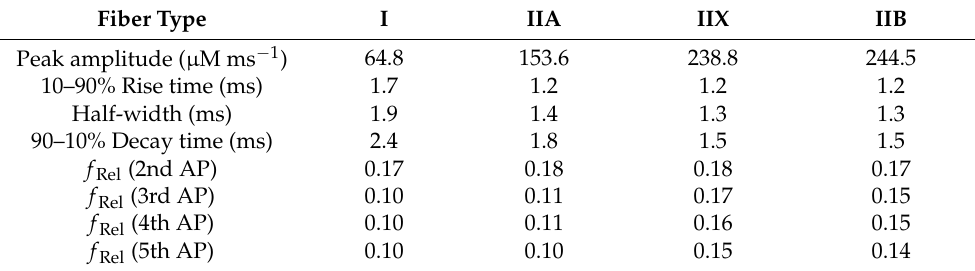
Table 2. Estimated kinetic parameters of the Ca 2+ release rate function a .